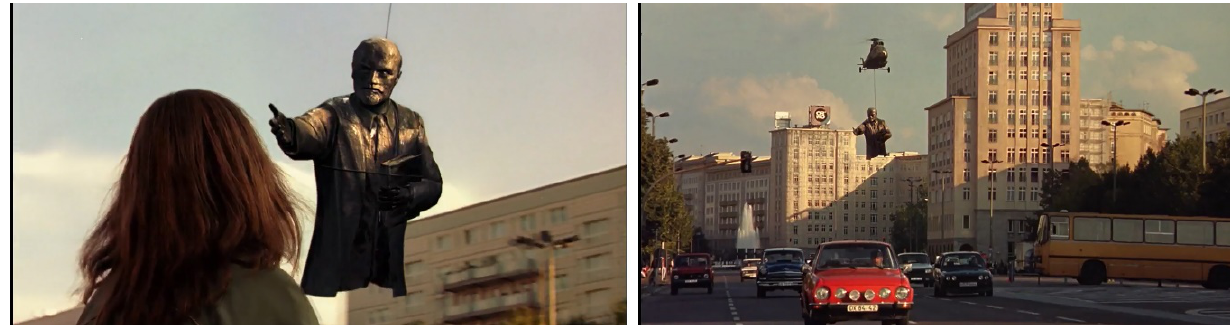
Figure 2 Mother and the flying